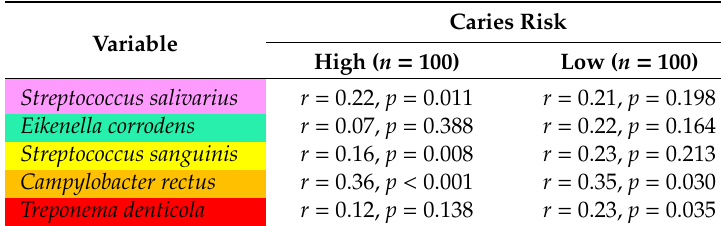
Table 6 details the e ff ect of BOIB on bacterial count according to caries risk. The quantity of S. salivarius and S. sanguinis significantly increased in the HCR group, whereas no significant e ff ect was observed for the LCR group. E. corrodens was not significantly correlated with the BOIB. T. denticola was significantly increased with the BOIB in the LCR group but not in the HCR group. C. rectus was correlated with the increase in BOIB in both groups. Table 6. Stratified analysis of the e ff ect of BOIB on bacterial counts 1 , according to caries risk level in 200 quadrants ( n = 50 patients x 4 quadrants / patient).